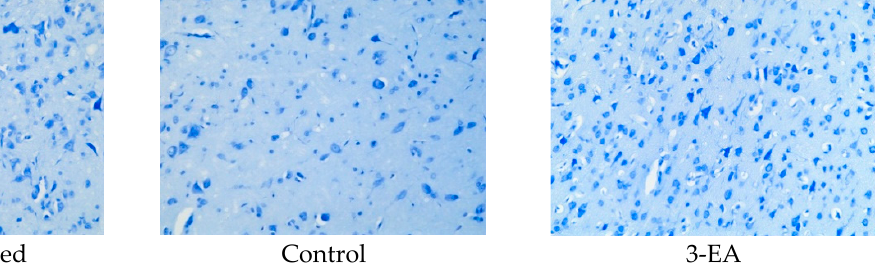
( D ) Brain cortex sections at the level of ischemic damage